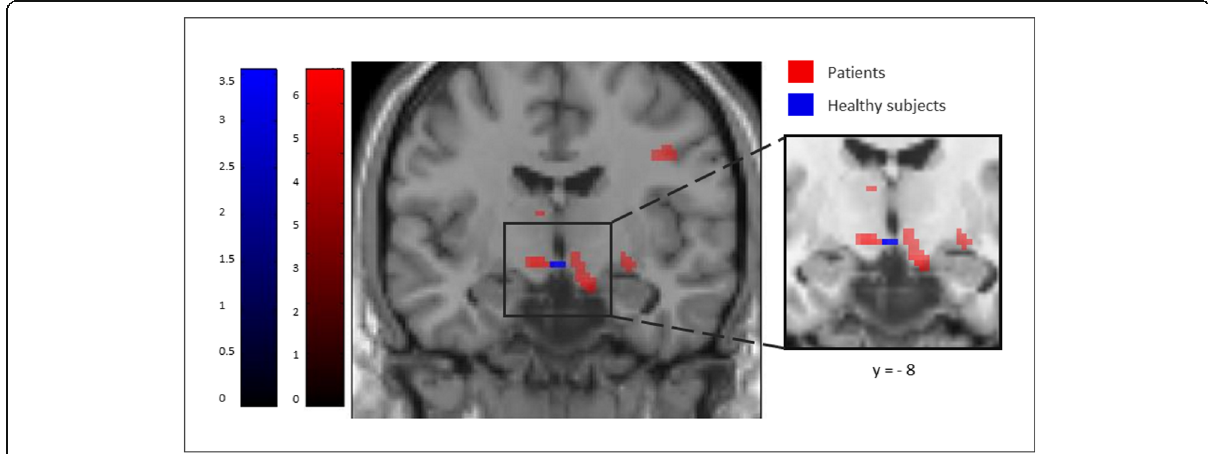
Fig. 4 Increased hypothalamic activation under Metoprolol during pain. At an exploratory threshold of p < 0.005 (uncorrected), hypothalamic activity is similarly increased in patients (red) and healthy subjects (blue) under metoprolol during trigeminal stimulation